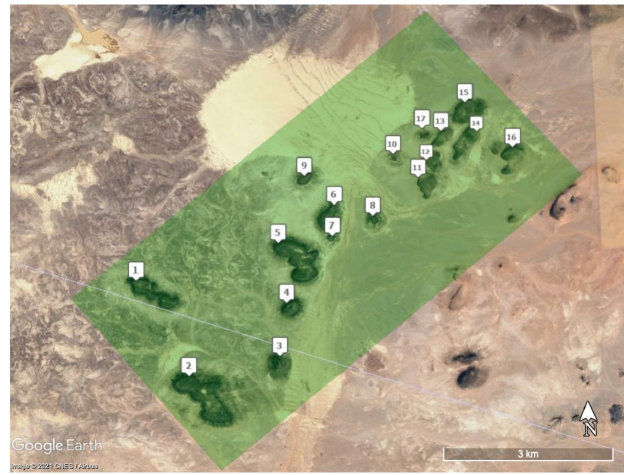
Figure 2. Wadi al-Qattafi aerial survey area with mesa numbering as established by the Aerial Photographic Archive for Archaeology in the Middle East (APAAME) project [32].